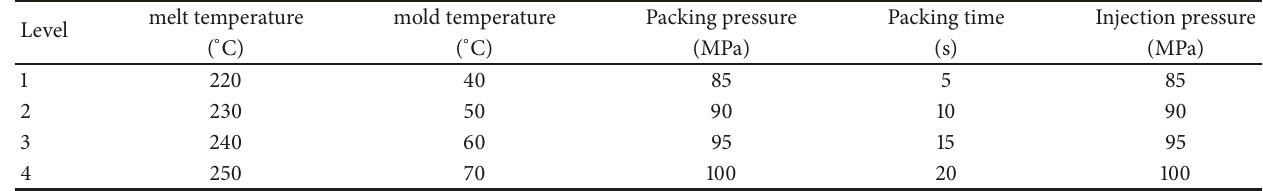
Table 1: Parameters of injection molding process.